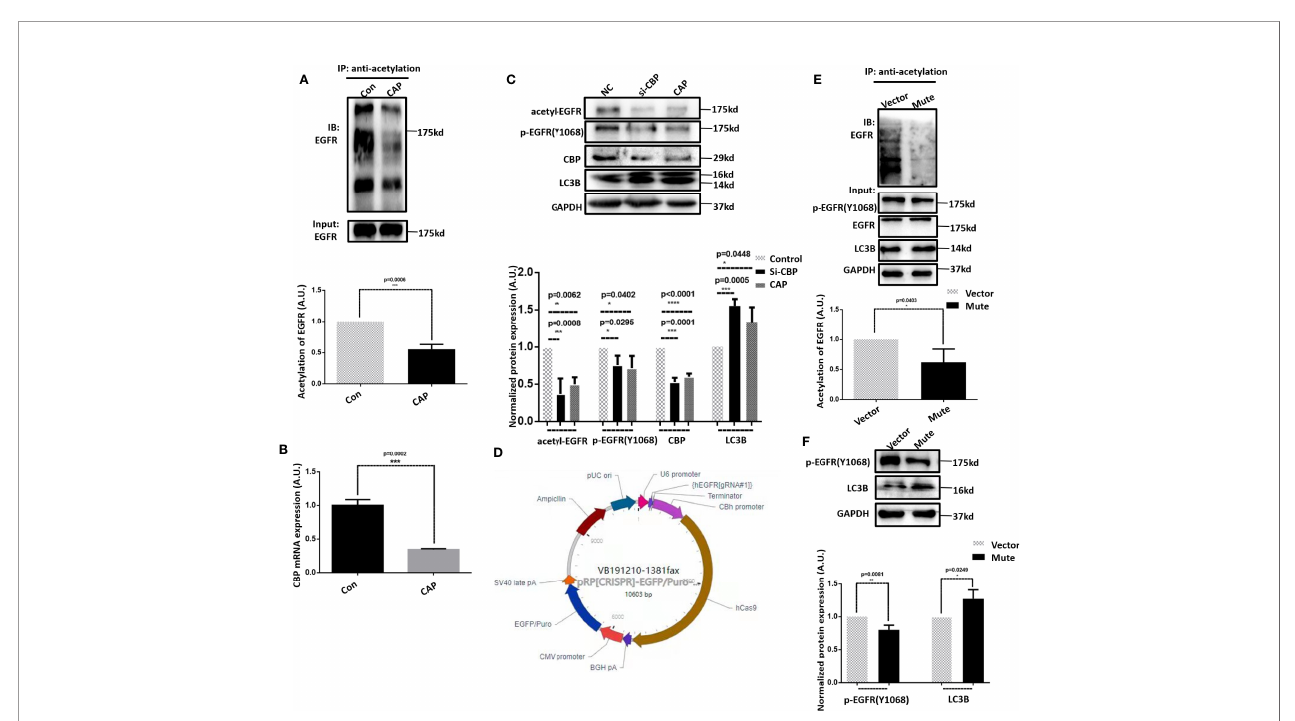
FIGURE 3 | CAP triggers autophagy in HCC cells via suppressing EGFR acetylation and EGFR(Tyr1068) phosphorylation. (A) Immunoprecipitation and its quanti fi cation showing EGFR acetylation with and without CAP treatment. (B) Q-PCR results showing the knockdown ef fi ciency of CBP. (C) Western blots and quanti fi cations showing the level of EGFR acetylation, EGFR(Tyr1068) phosphorylation, and LC3B. (D) Plasmid structure generating EGFR(Tyr1068) mutation. (E) Immunoprecipitation and its quanti fi cation showing EGFR acetylation with and without EGFR(Tyr1068) mutation. (F) Western blots and quanti fi cations showing the level of EGFR(Tyr1068) and LC3B. Quanti fi cations were made from triplicates. *, **, ***, ****: statistical signi fi cance. ns: there is no statistical signi fi